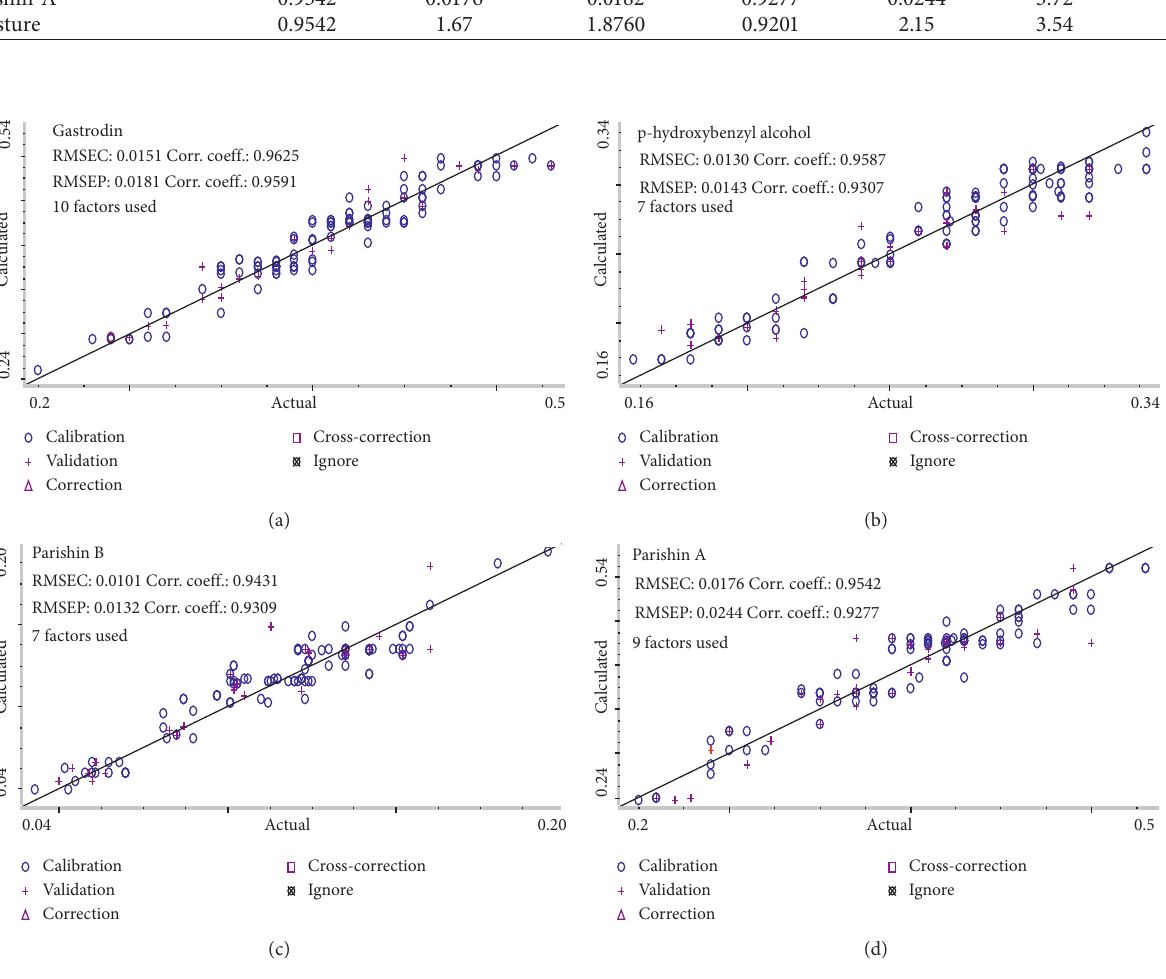
Figure 8: Prediction results of the four PLS models: (a) gastrodin, (b) p- hydroxybenzyl alcohol, (c) parishin B, and (d) parishin